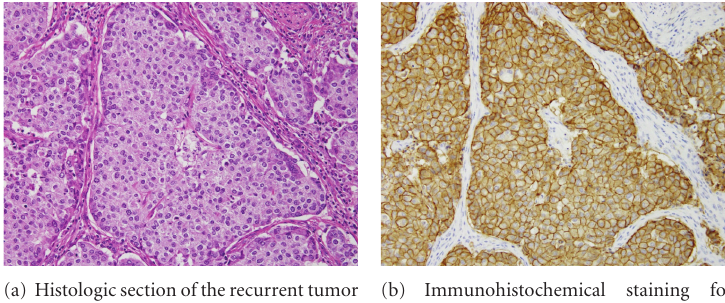
Figure 1: Histologic and immunohistochemical findings of the recurrent tumor.